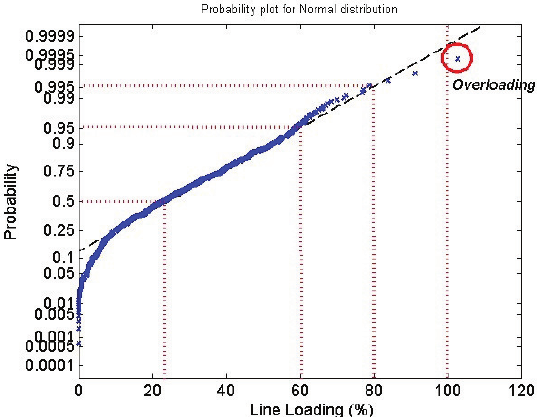
Figure 12. Distribution probability of line loading in the FirstEnergy/PJM transmission system—base